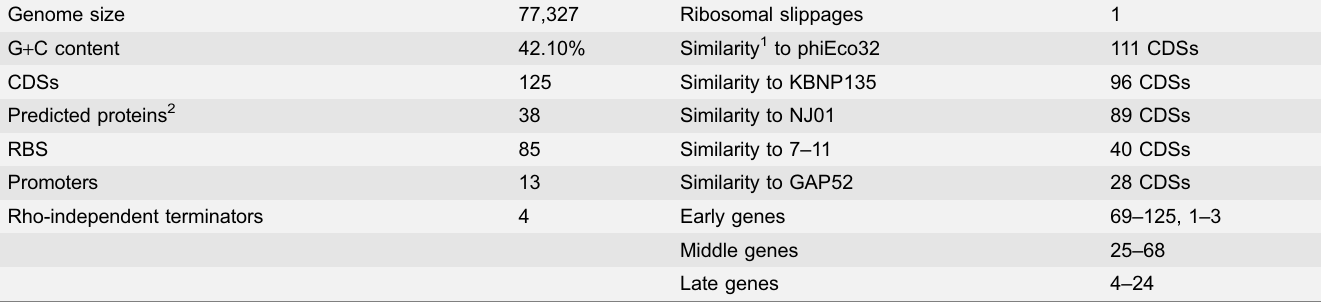
Table 1. General features of the phage SU10